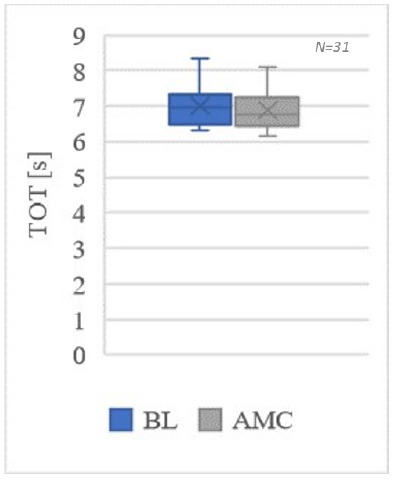
Figure 9. Boxplot for take-over time (TOT). The x represents the mean value.